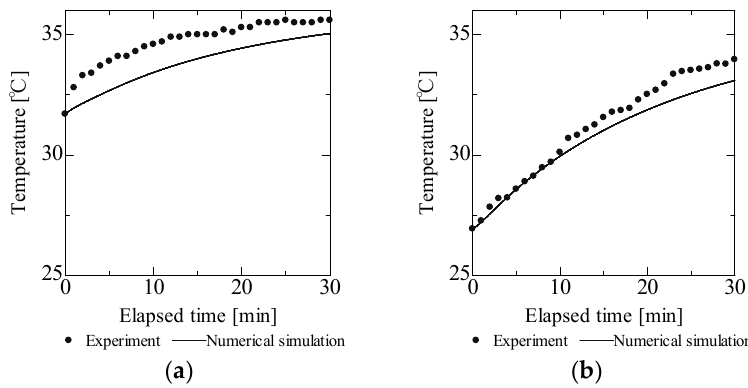
Figure 6. Comparative measured and predicted time-dependent temperature distributions for the EVA08 material at 25 °C: ( a ) 45 beats/min gait frequency; ( b ) 75 beats/min gait